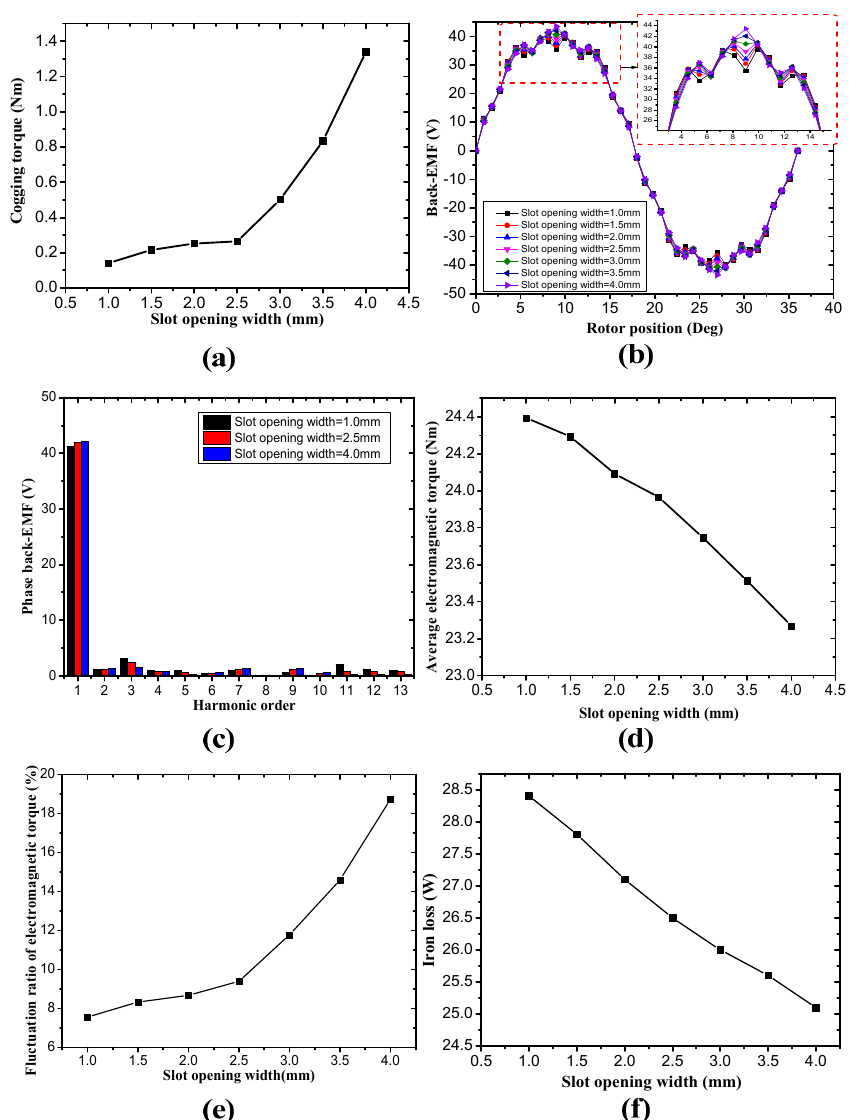
Figure 12. Influence of the slot opening width ( a ) Cogging torque ( b ) Back—EMF ( c ) Harmonic analysis of the phase back—EMF ( d ) Average electromagnetic torque ( e ) Fluctuation ratio of electromagnetic torque ( f ) Iron loss.